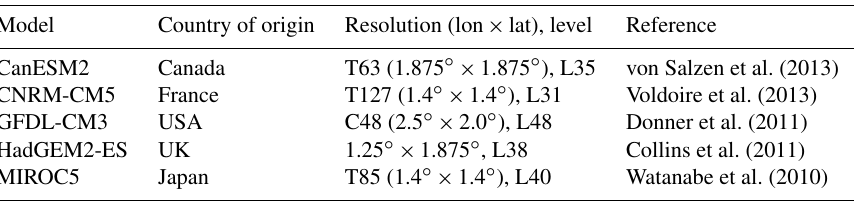
Table 1. CMIP5 models used in this study with information on the country of origin and resolution of the models (L refers to number of vertical levels, T to triangular truncation and C to cubed sphere).